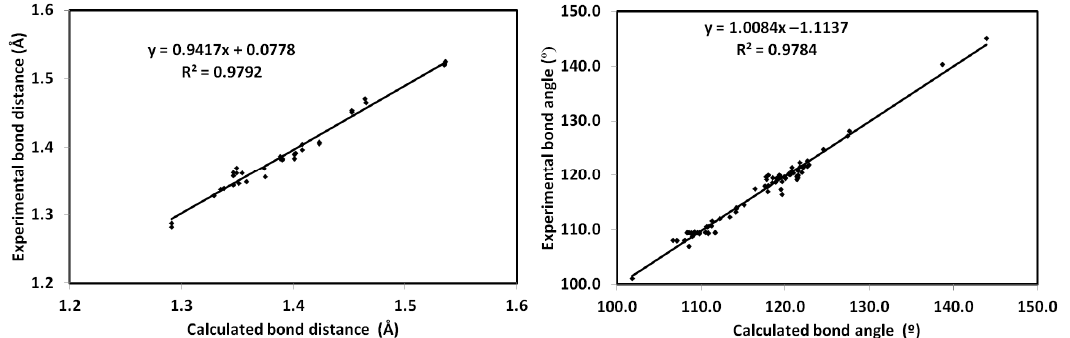
Figure 10. The calculated structure ( left ) of 4 and its overlay with the experimental one ( right ).